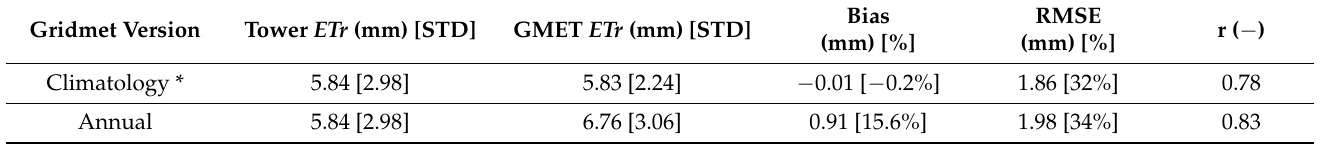
Table 4. Flux Tower Alfalfa Reference Evapotranspiration ( ETr ) comparison with Gridmet Alfalfa